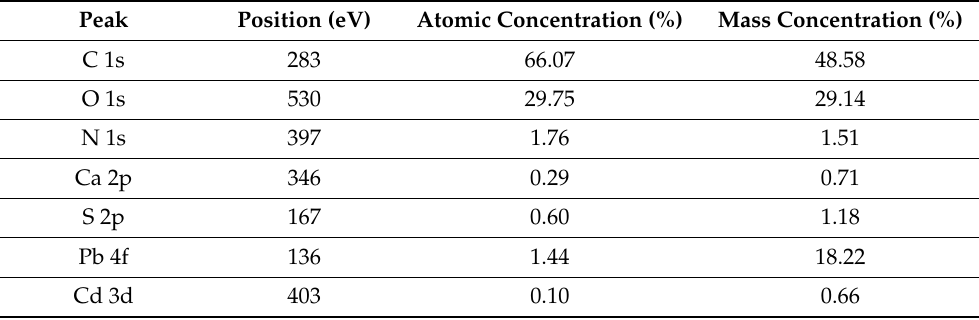
Table 6. Quantification of elements on the surface of Sargassum biomass used in competitive adsorp- tion experiments.